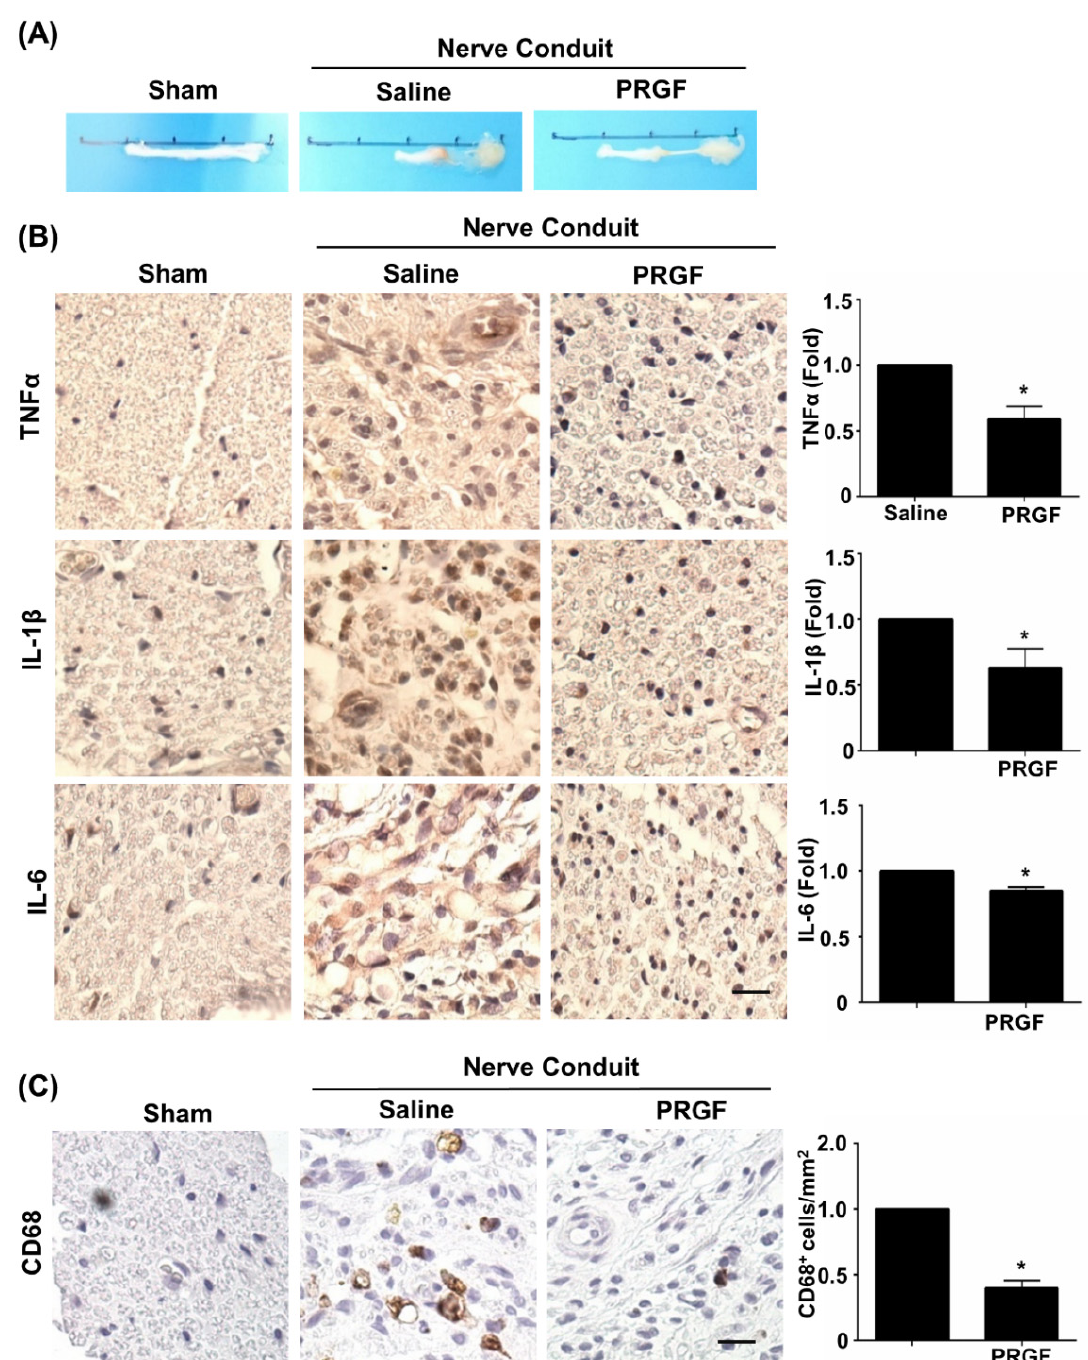
Figure 3. PRGF reduces chronic inflammation and macrophages in nerve conduit. ( A ) Representative pictures of the harvested sciatic nerves after 6 weeks of transection injury and nerve conduit surgery. ( B ) Representative immunohistochemistry (IHC) staining images demonstrated the expression levels of TNF α , IL-1 β , and IL-6 in the middle region of transverse sectioned nerve tissue were significantly decreased in the rats that received nerve conduit filled with PRGF. ( C ) The number of M1 macrophages as indicated by the positive marker of CD68 was reduced in PRGF-treated nerve tissue. Scale bar = 20 µ m. N = 3. Significance was assessed by paired t -test. Data are presented as the mean ± SEM. * p < 0.05 versus to saline group.